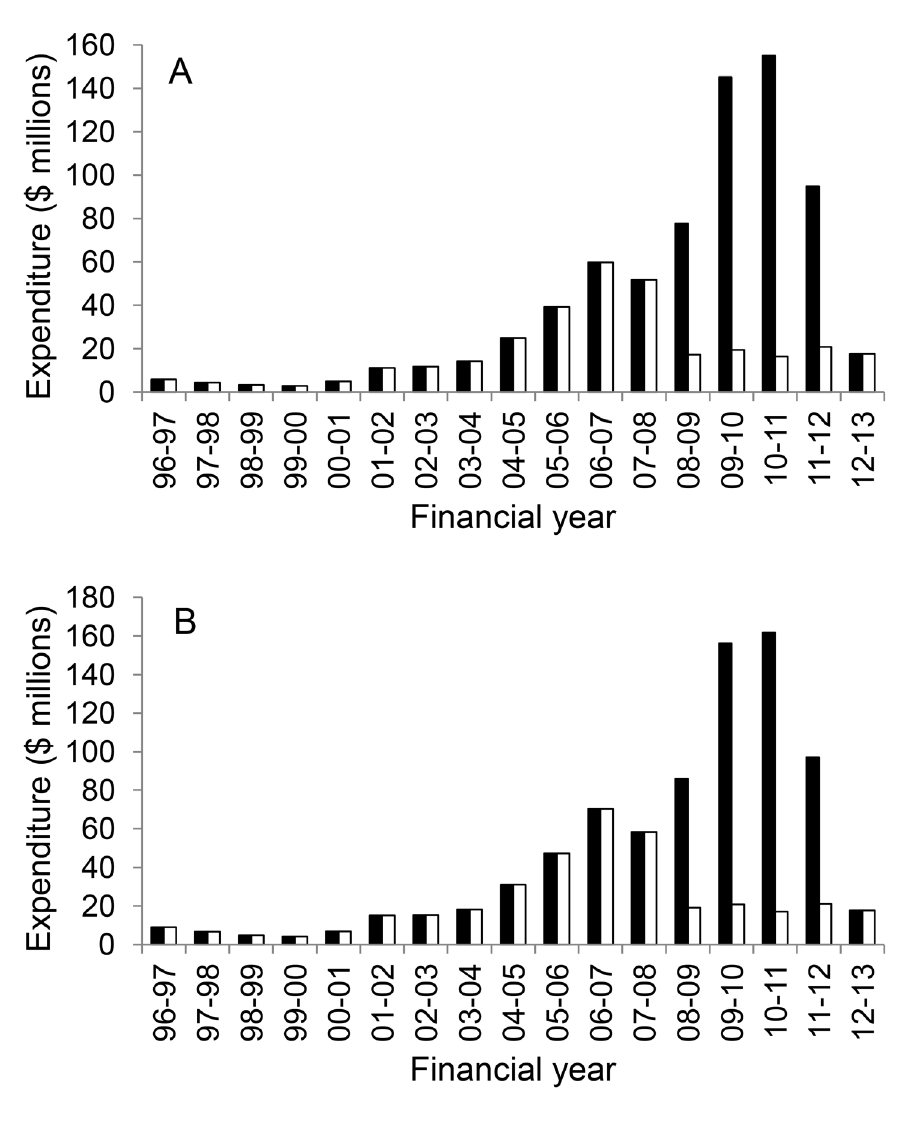
Figure 1. Total expenditure of federal grants per financial year for invasive species management with base-level funding included (black) and excluded (white) using A actual data, and B data adjusted for inflation to 2013